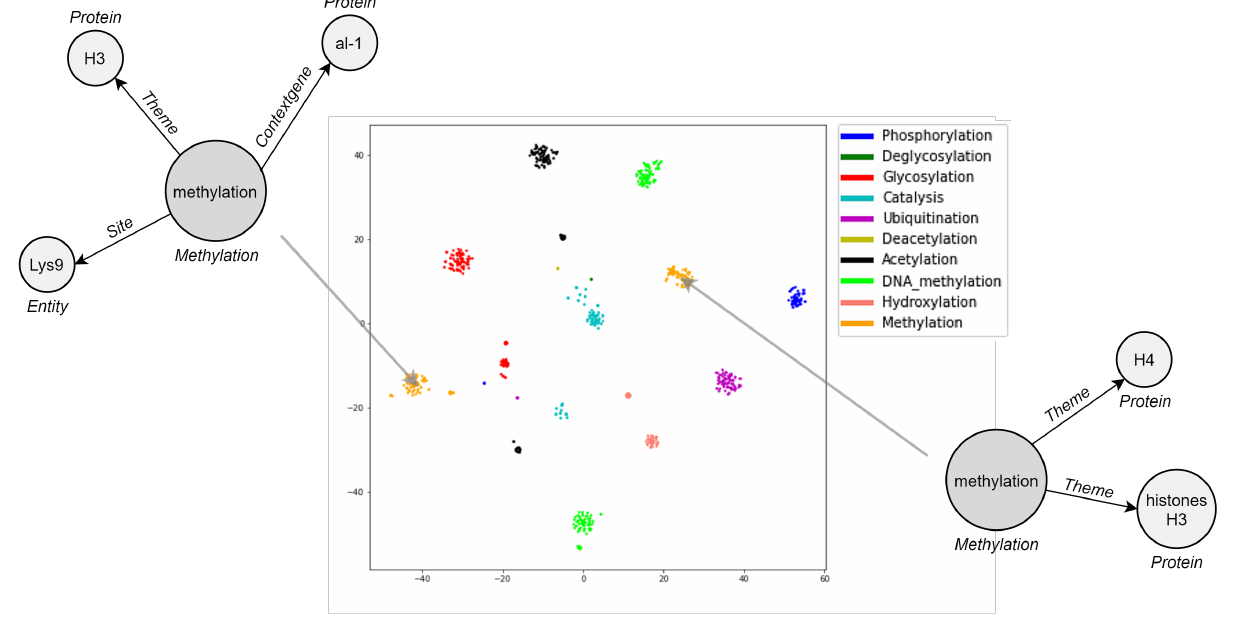
Figure 9. Embeddings of 1002 biomedical events from the EPI11 dataset, projected into a 2D space by t-SNE. Event graphs belonging to the same type are embedded closer to each other. In the case of structural or semantic differences, there can be multiple clusters for the same event type, as qualitatively shown for